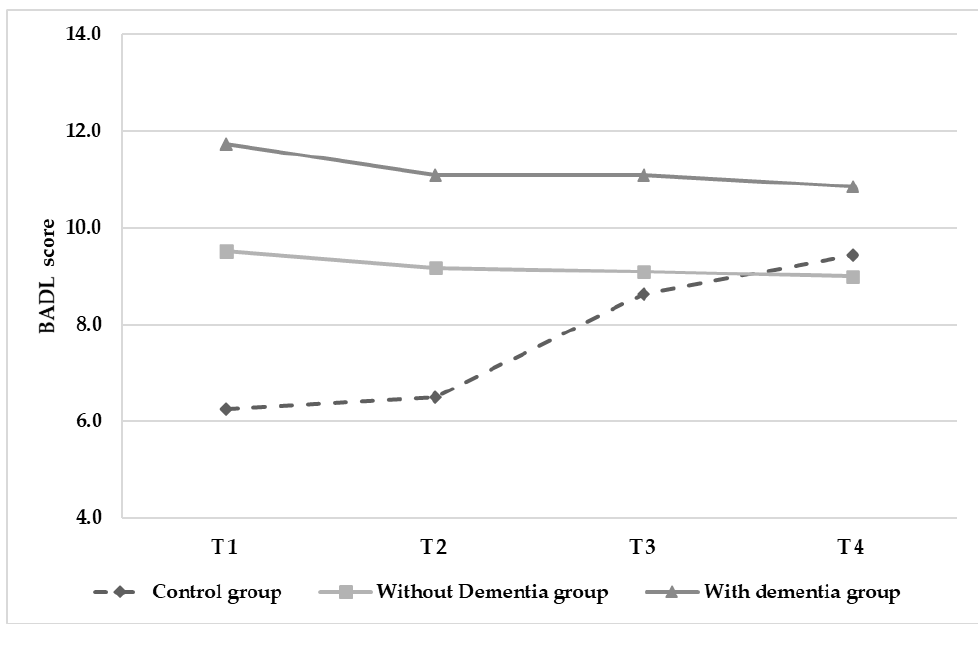
Figure 5. Changes in autonomy (BADL) score over time.